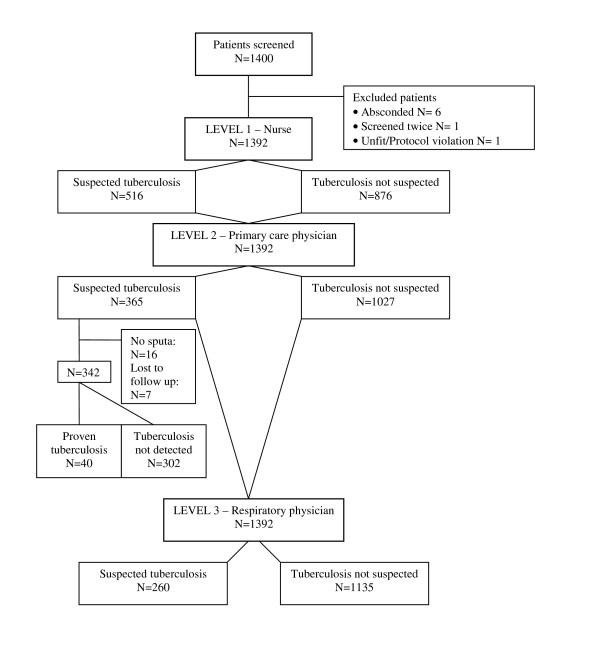
Flow chart of patients with diagnoses of suspected tuberculosis as made by nurse, primary care physician and respiratory physician, and proven tuberculosis as made by the primary care physician.